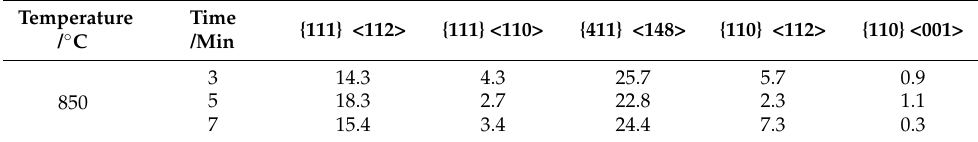
Figure 2. ODFs of texture on the surface of decarbonized annealing samples ( ϕ 2 = 45 ◦ ): ( a ) 850 ◦ C × 3 min; ( b ) 850 ◦ C × 5 min; ( c ) 850 ◦ C × 7 min. Table 2. Content of main texture of decarbonized annealing samples (%).